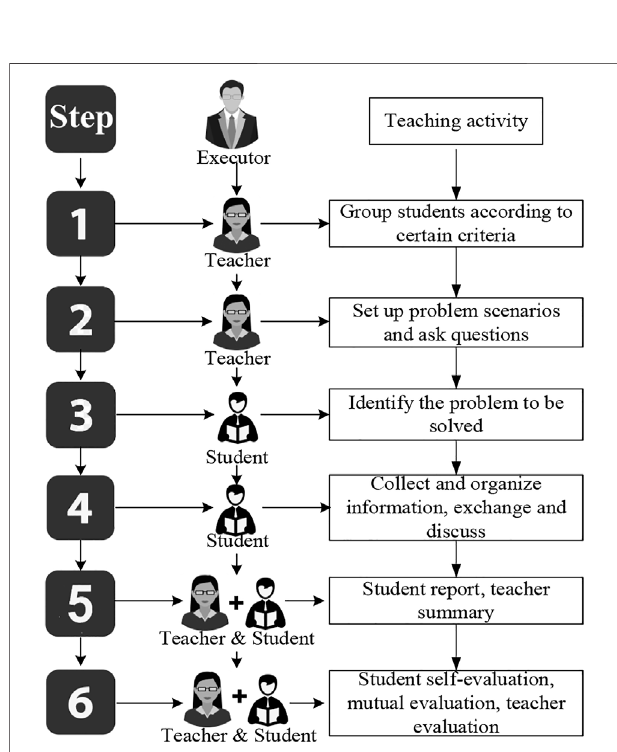
FIGURE 2 | The teaching process of PBL teaching